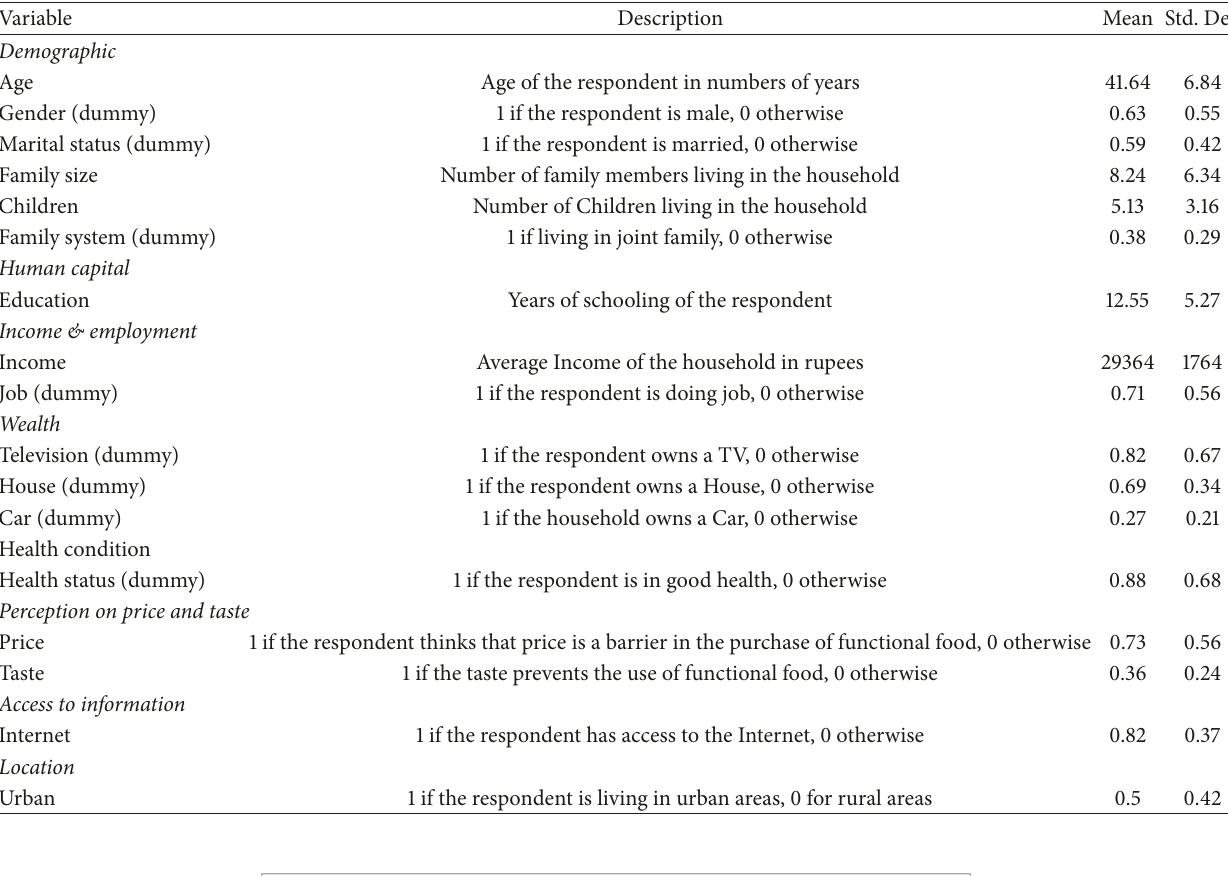
Table 2: Data and description of variables.